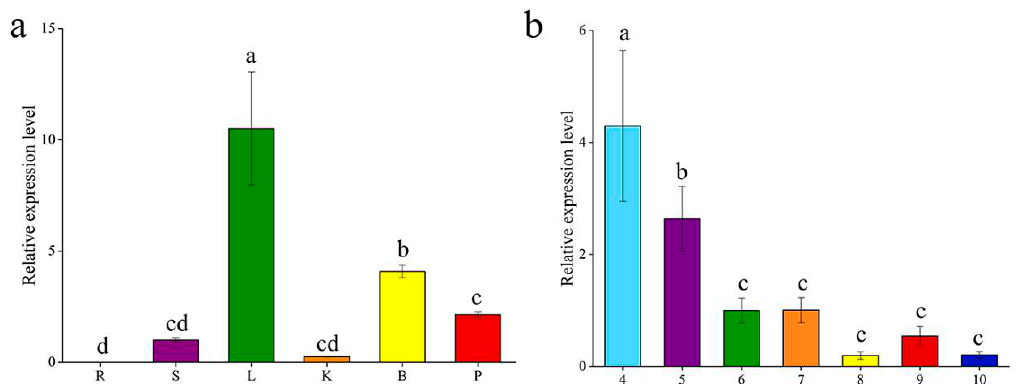
Figure 3. Transcriptional profiling of GbHMGS1 in ginkgo: ( a ) Variation in transcript abundance among plant tissues; ( b ) Expression analysis of the GbHMGS1 gene in ginkgo leaves at different times. R: roots; S: stems; L: leaves; K: kernels; B: buds; P: petioles; 4 to 10 refer to April, May, June, July, August, September, and October, respectively. The data are presented as the means from triplicate experiments ( n =